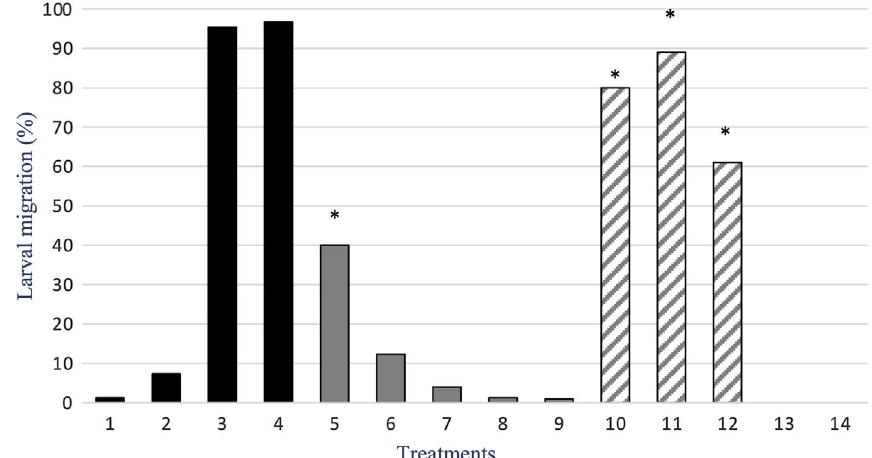
Figure 4. Percentage (%) of inhibition of gastrointestinal strongyle larval migration by fi ve concentrations of Glycyrrhiza glabra aqueous extract and of glycyrrhetinic acid. Columns 1: Untreated, 2: DMSO, 3: Thiabendazole, 4: Thiabendazole plus DMSO, 5: 30 mg/mL, 6: 10 mg/mL, 7: 5 mg/mL, 8: 1 mg/mL, 9: 0.5 mg/mL of G. glabra , and 10: 30 mg/mL, 11: 10 mg/mL, 12: 5 mg/mL, 13: 1 mg/mL, 14: 0.5 mg/mL of glycyrrhetinic